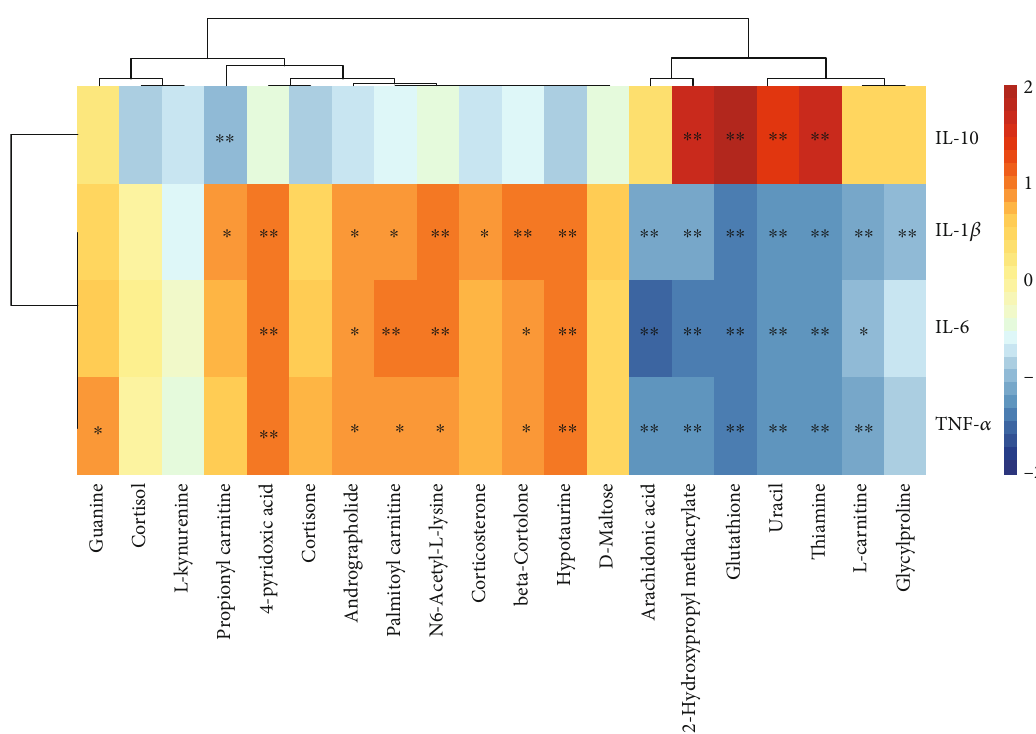
Figure 6: The Spearman correlation analysis among cytokines and biomarkers, and clustering is shown as a heat map. Color from red to blue indicates a positive correlation to a negative correlation, and the asterisk represents the signi fi cance of the correlation, ∗ P < 0 : 05 , ∗∗ P < 0 : 01